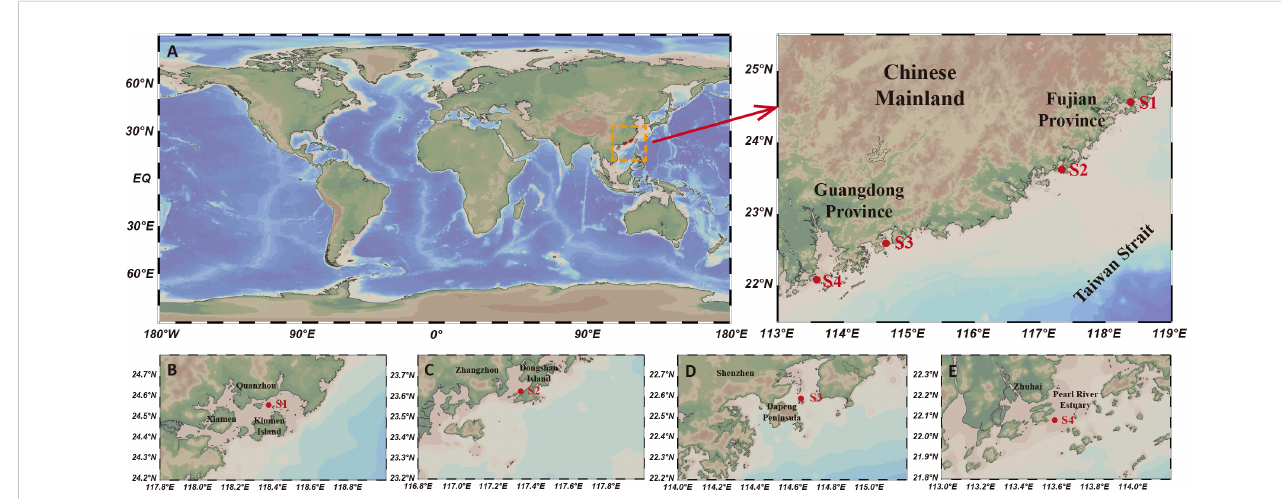
FIGURE 1 (A) An overall view of the location of the experimental sites S1, S2, S3 and S4 from both a global and regional context, with the four recording sites marked in red. (B) Recording site at Xiamen Bay (Xiamen, China), (C) Zhao'an Bay (Zhangzhou, China), (D) Daya Bay (Shenzhen, China) and (E) Pearl River estuary (Zhuhai, China). Figure was drawn using Ocean Data View (Schlitzer, R., Ocean Data View, https://odv.awi.de,